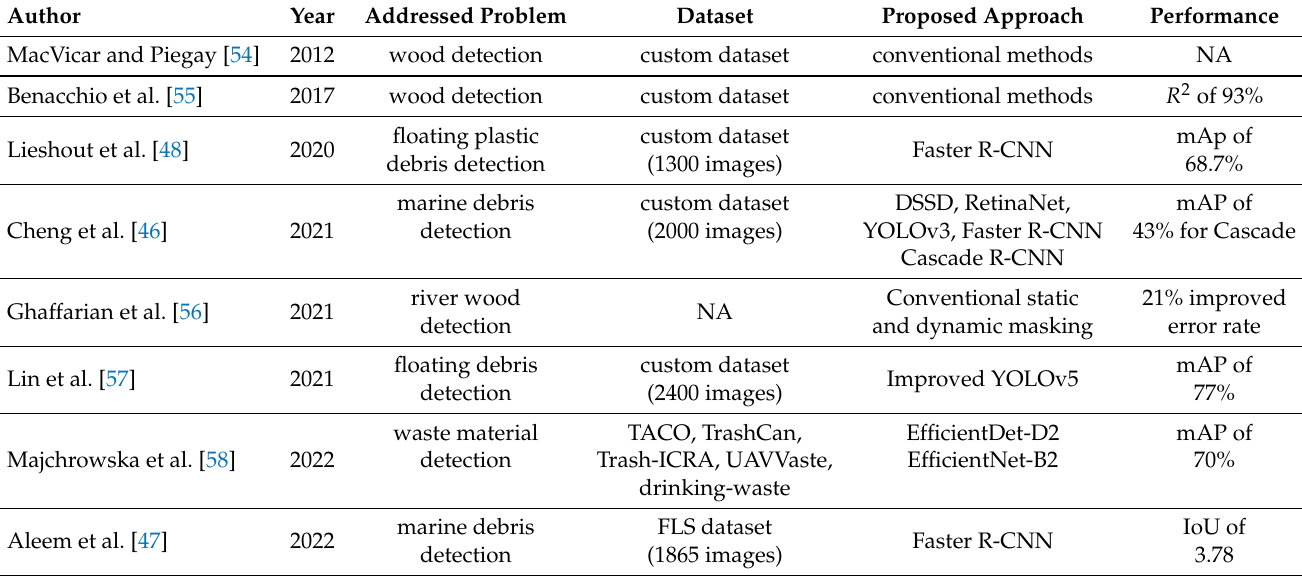
Table 1. Summary of Benchmark Literature Related to the Detection of Different Debris Types using Computer Vision